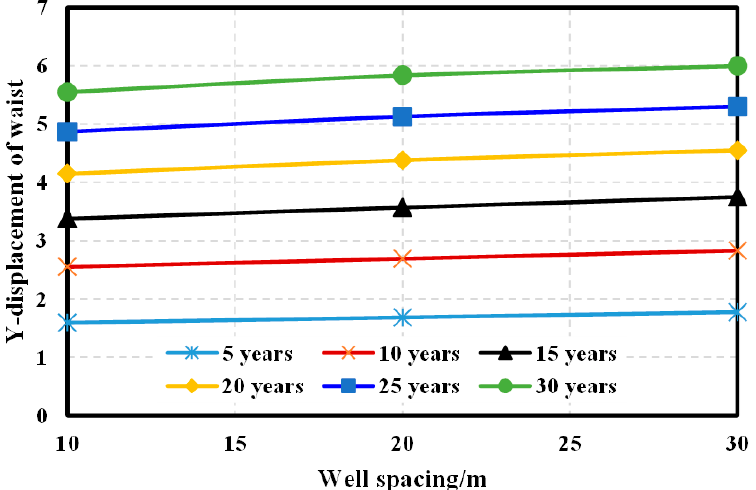
Figure 15. X ‐ displacement of cavern waist with different well spacings at different operating times.